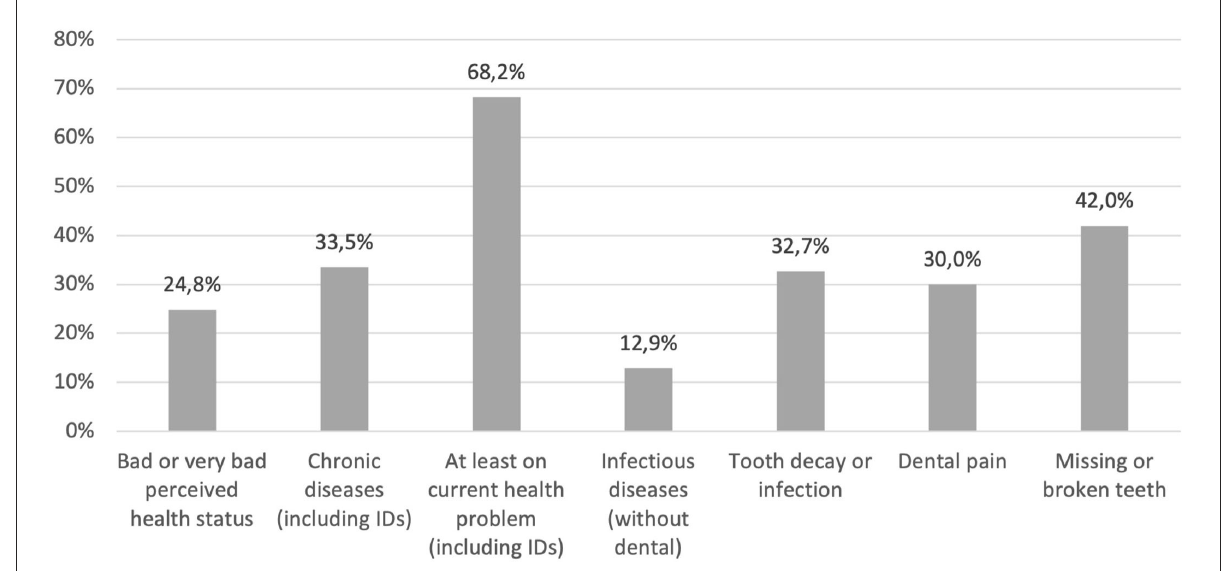
FIGURE1 Frequency of health problems and infectious diseases among undocumented migrants in Paris and Bordeaux, Premier Pas survey ( n = 1.188).